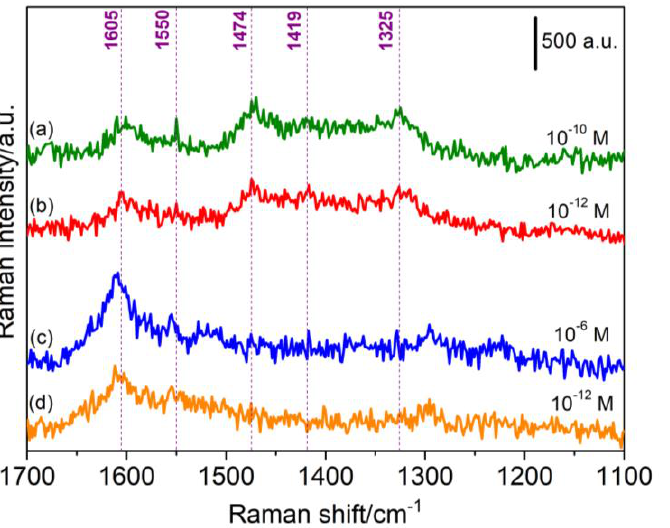
Figure 10. ( a , b ) SERS spectra shown by Porous-A NWs for bipy concentration of 10 − 10 M and 10 − 12 M respectively. ( c , d ) SERS spectra shown by nanoporous FePd thin film for bipy concentration of 10 − 6 M and 10 − 12 M respectively.